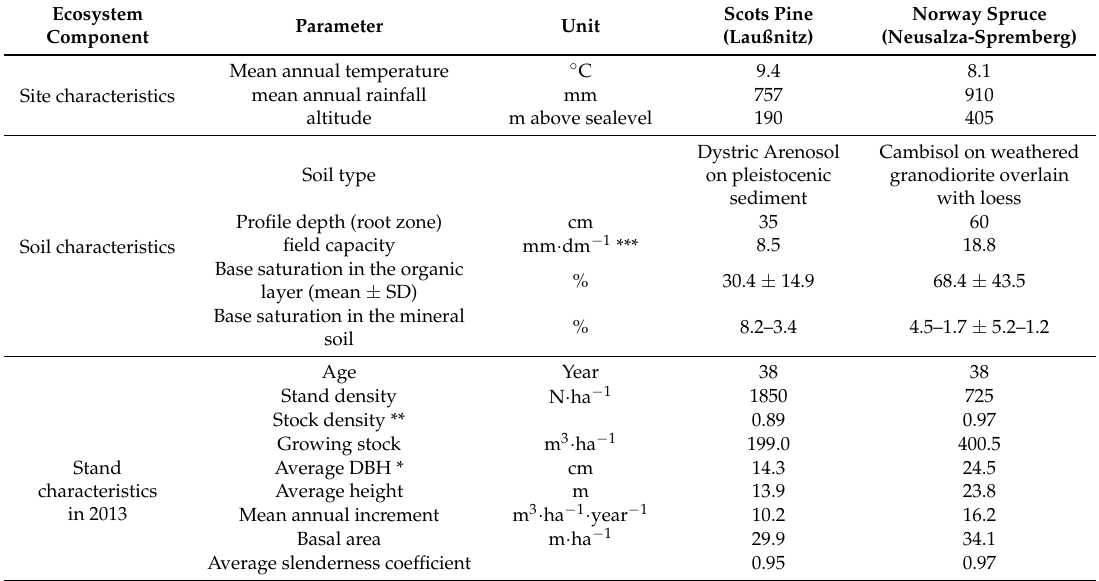
Table 1. Site and stand characteristics of the studied Scots pine and Norway spruce stand in